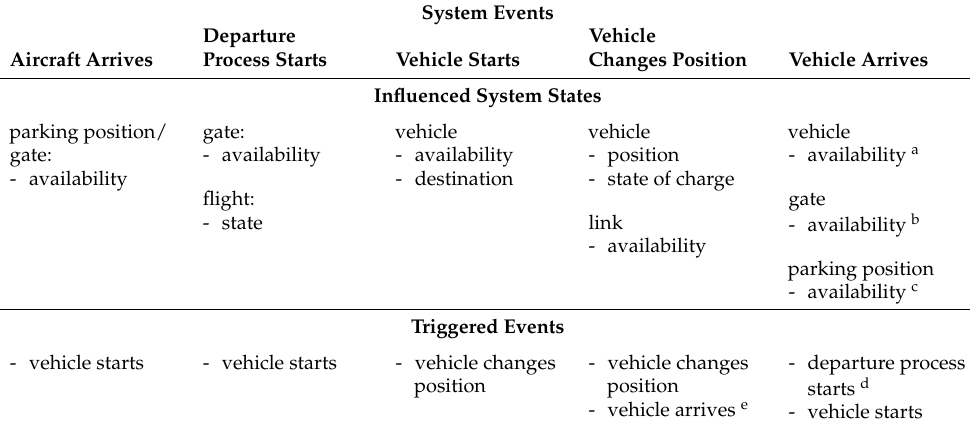
Table A2. Events of the